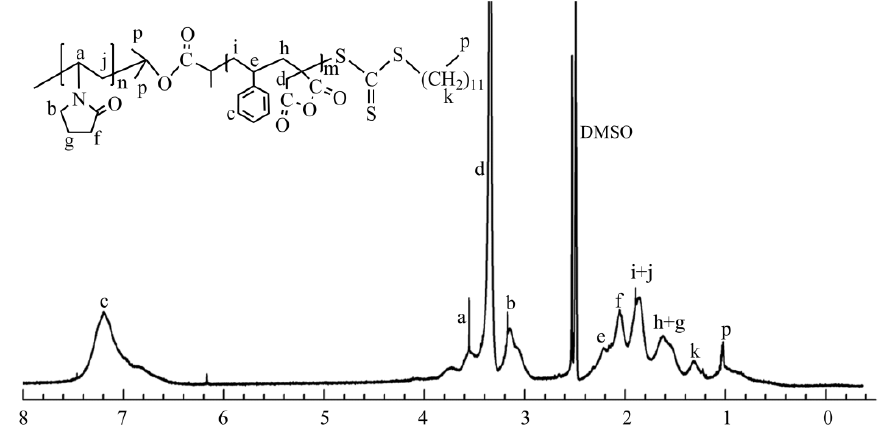
Figure 5. 1 H-NMR Spectrum of polymer PVP- b -P (St/ITA).